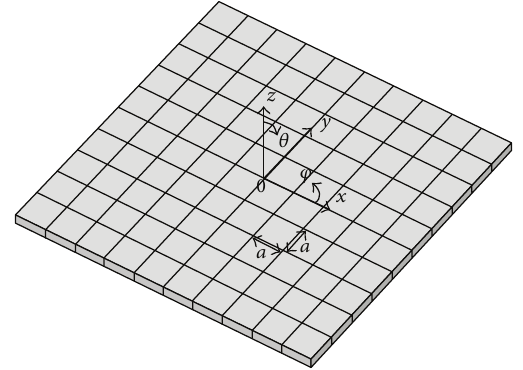
Figure 1: Sketch plot of a planar metasurface consists of 𝑁 𝑥 × 𝑁 𝑦 reflecting elements in square